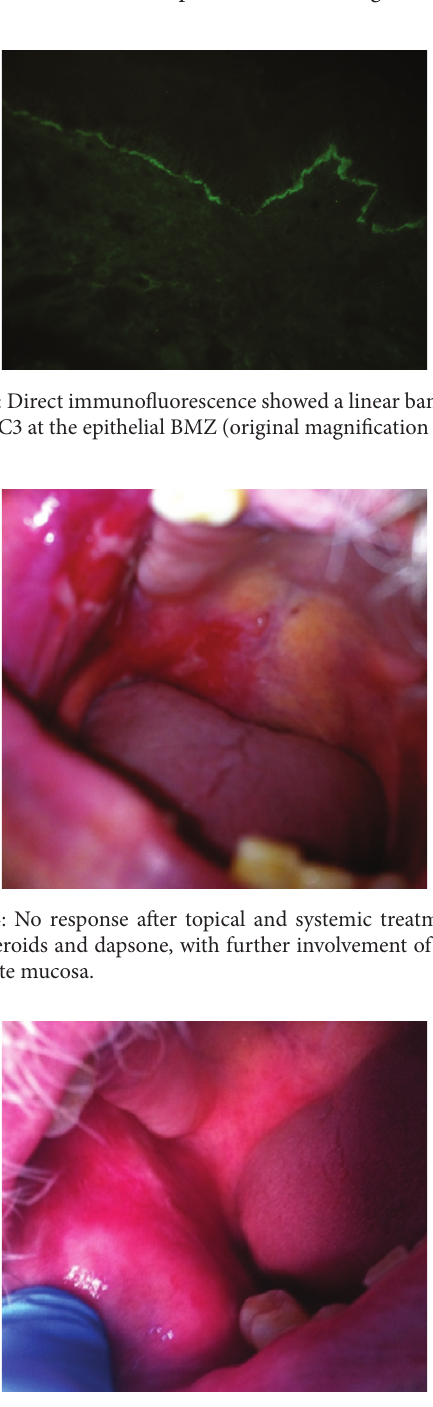
Figure 5: Complete response after IVIg therapy and only a delicate white pattern of reticulated scarring on the buccal mucosa had been seen after 3 years of